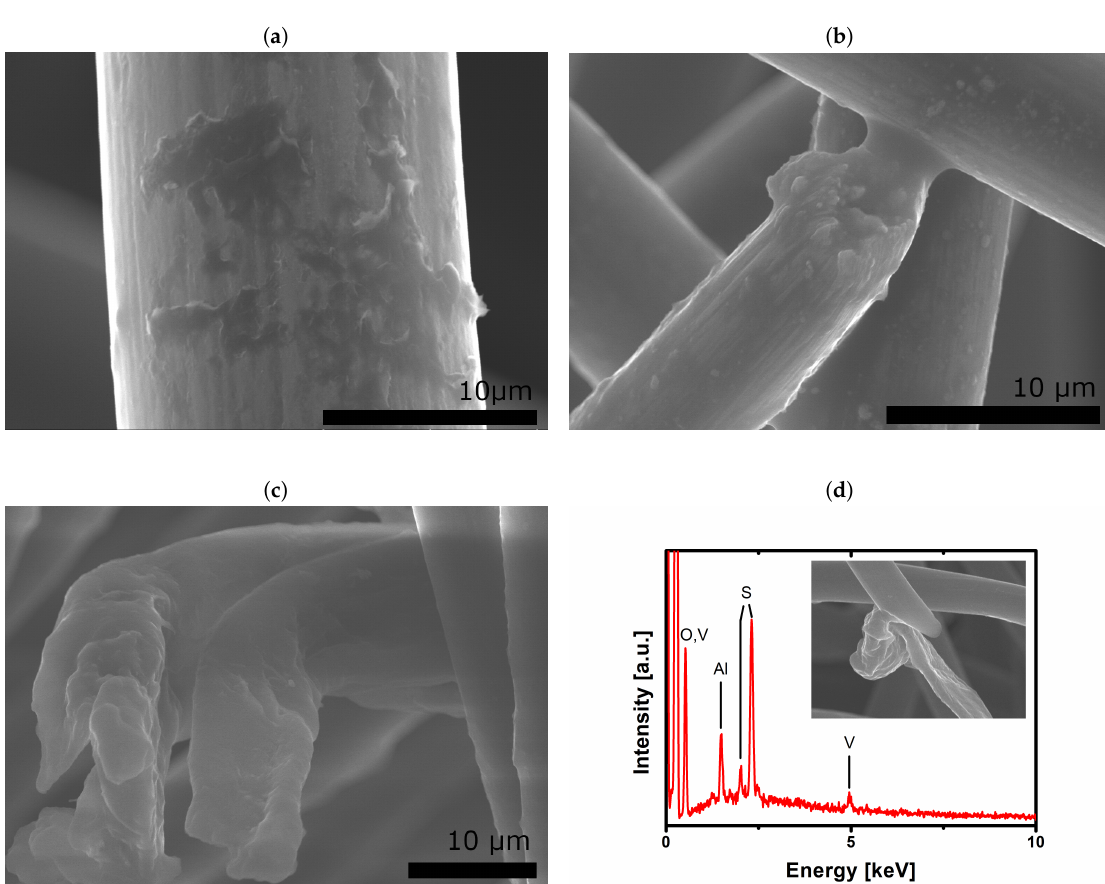
Figure 5. SEM images of aged carbon felts: ( a ) unmodified GFD-A; ( b , c ) Bi-modified Bi-GFD-A; ( d ) EDX spectrum of Bi-GFD-A recorded at the spot shown in the